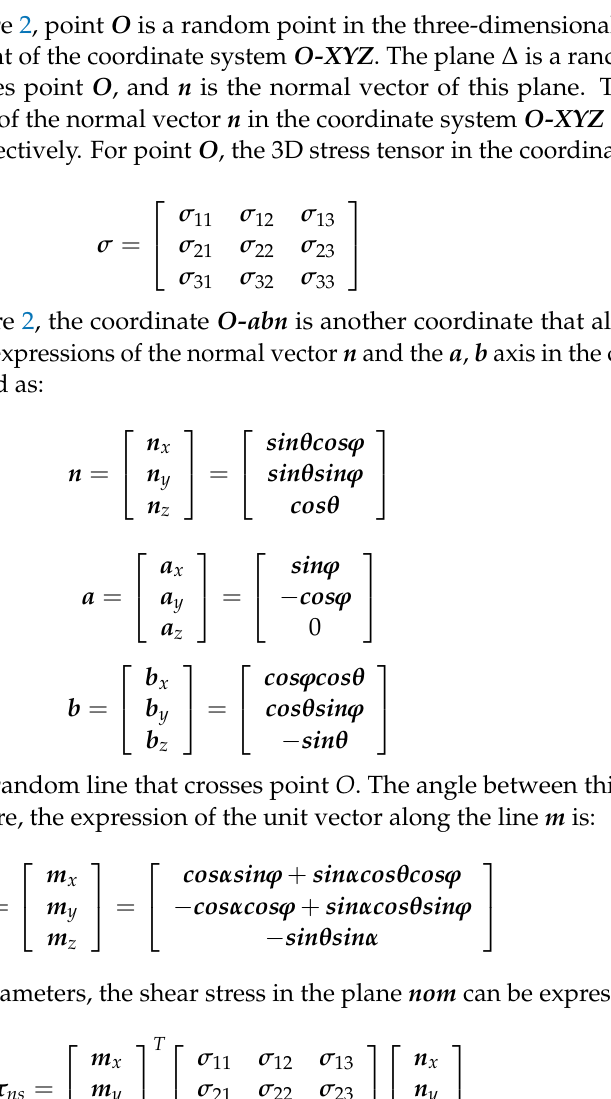
Figure 2. A random plane crossing the calculation